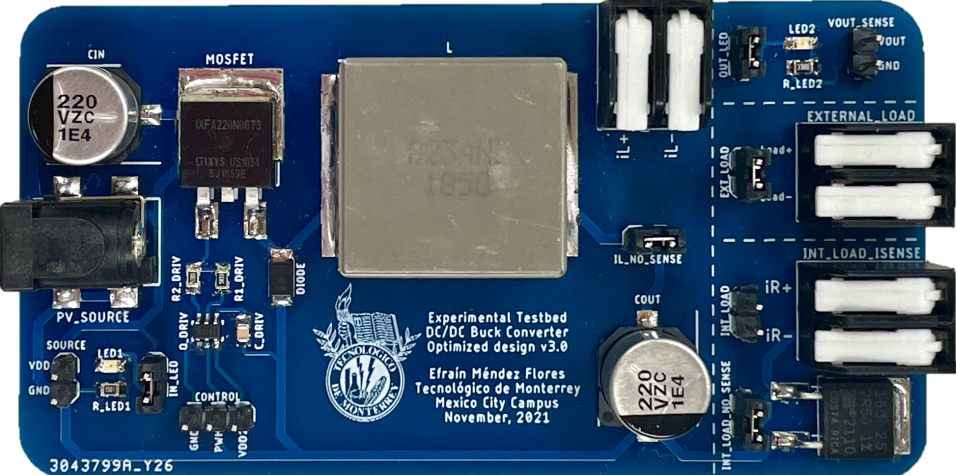
Figure 25. Manufactured PCB for the DC–DC converter optimally designed for the PV